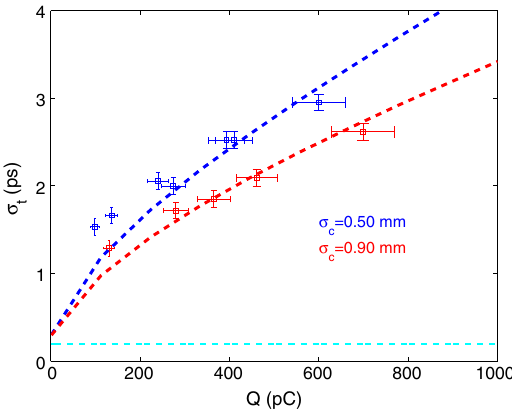
FIG. 11. Measured spatiotemporal ð x / t; y Þ distribution and associated projections (white solid lines) with parabolic fit (green dash lines). The beam density is measured at the Ce:YAG screen XS3 (see Fig. 2) for Q ¼ 100 (cid:5) 20 pC (a) and Q ¼ 480 (cid:5) 30 pC (b).